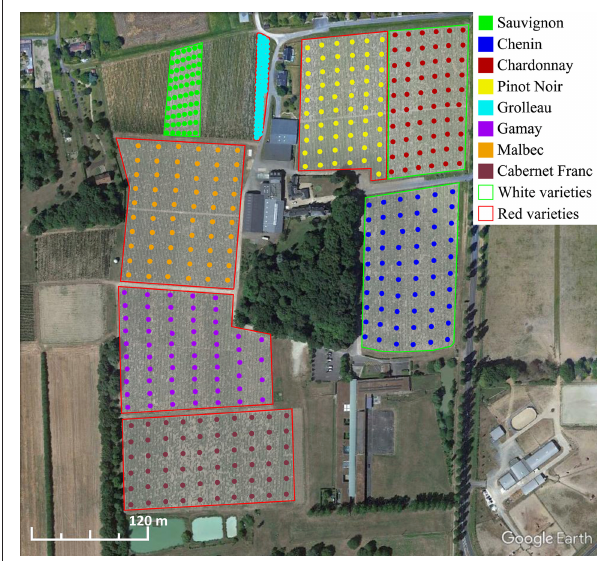
FIGURE 2 | Location of the vineyard plots planted with the 8 different grape varieties in Amboise (Loire Valley, France). Grape stems were randomly pruned across the total area of each plot as indicated by circle